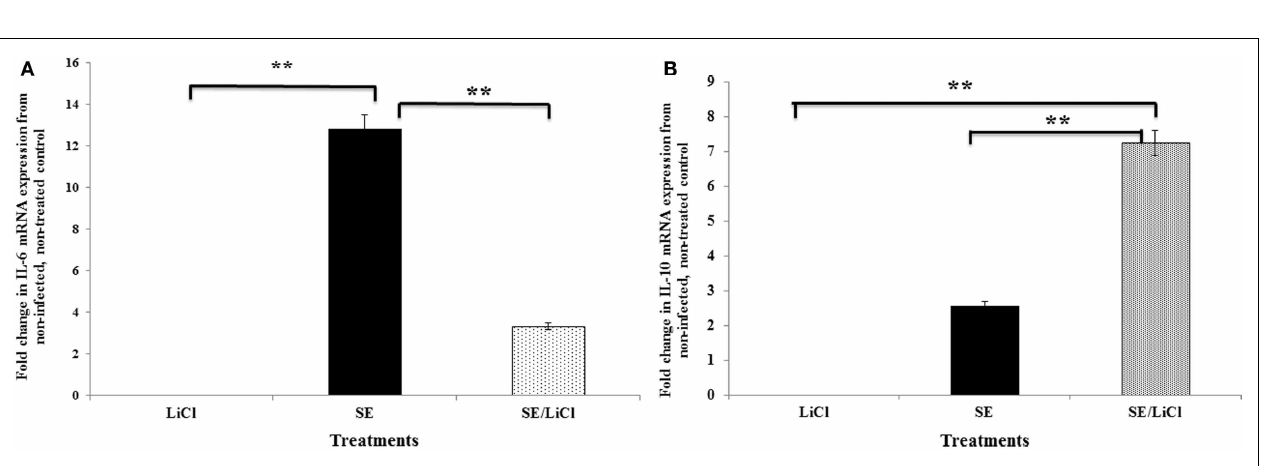
(Sr9) activity in avian heterophils after 30 and 60min stimulation with S . Enteritidis. Data presented as mean±SEM from three separate experiments. * p ≤ 0.01.